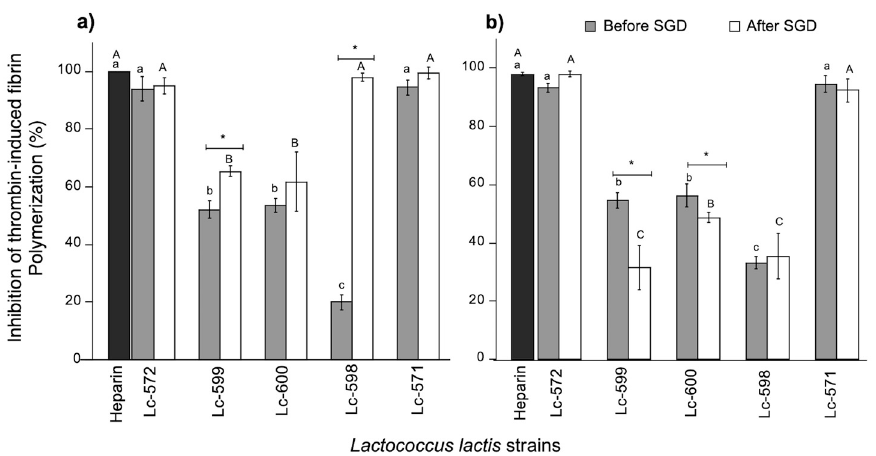
Figure 2. Inhibition (%) of thrombin-induced fibrin polymerization by WSF derived from fermented milk with 24 ( a ) and 48 h ( b ), before and after simulated gastrointestinal digestion (SGD). Different letters represent significant differences ( p < 0.05) among strains before (lowercase, a – c) and after (uppercase, A –C ) SGD. Asterisk (*) represents significant differences ( p < 0.05) before and after SGD. Data are the average (± SD) of triplicate samples.